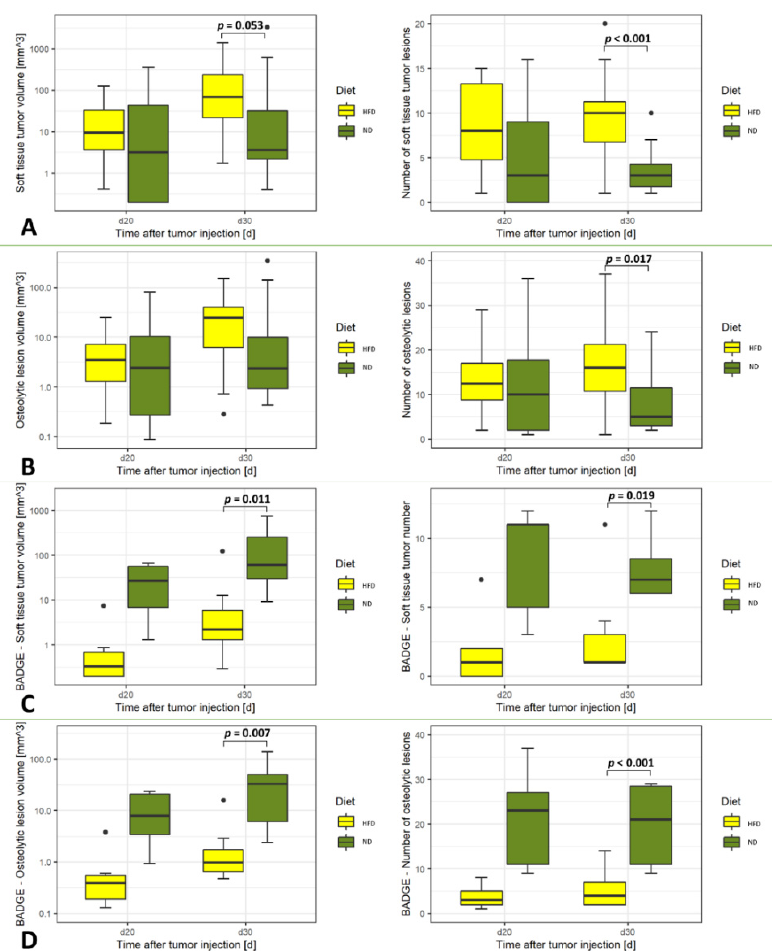
Figure 1. Morphologic tumor characteristics of the main ( A , B ) and the control ( C , D ) experiments. ( A ) Soft tissue tumor volume and number of lesions from MRI T2-weighted imaging ( B ) Osteolytic lesion volume and number of lesions determined with CT imaging. ( C ) Soft tissue tumor volume and number of lesions from MRI T2-weighted imaging under inhibition of the PPAR γ pathway with BADGE ( D ) Osteolytic lesion volume and number of lesions determined with CT imaging under inhibition of the PPAR γ pathway with BADGE. Volumes of osteolytic lesions and soft tissue tumors are given in mm 3 . Statistical analyses have been made with two-way ANOVA and Mann-Whitney- Wilcoxon U test. Significant values are defined as p < 0.05. Values of p are indicated up to a value of 0.15.